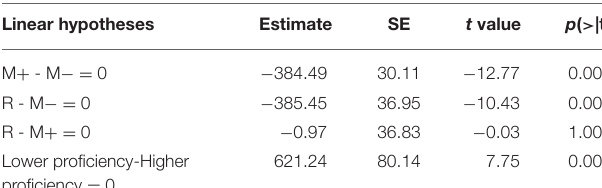
TABLE 7 | Tukey post-hoc test of response time in semantic relatedness judgment